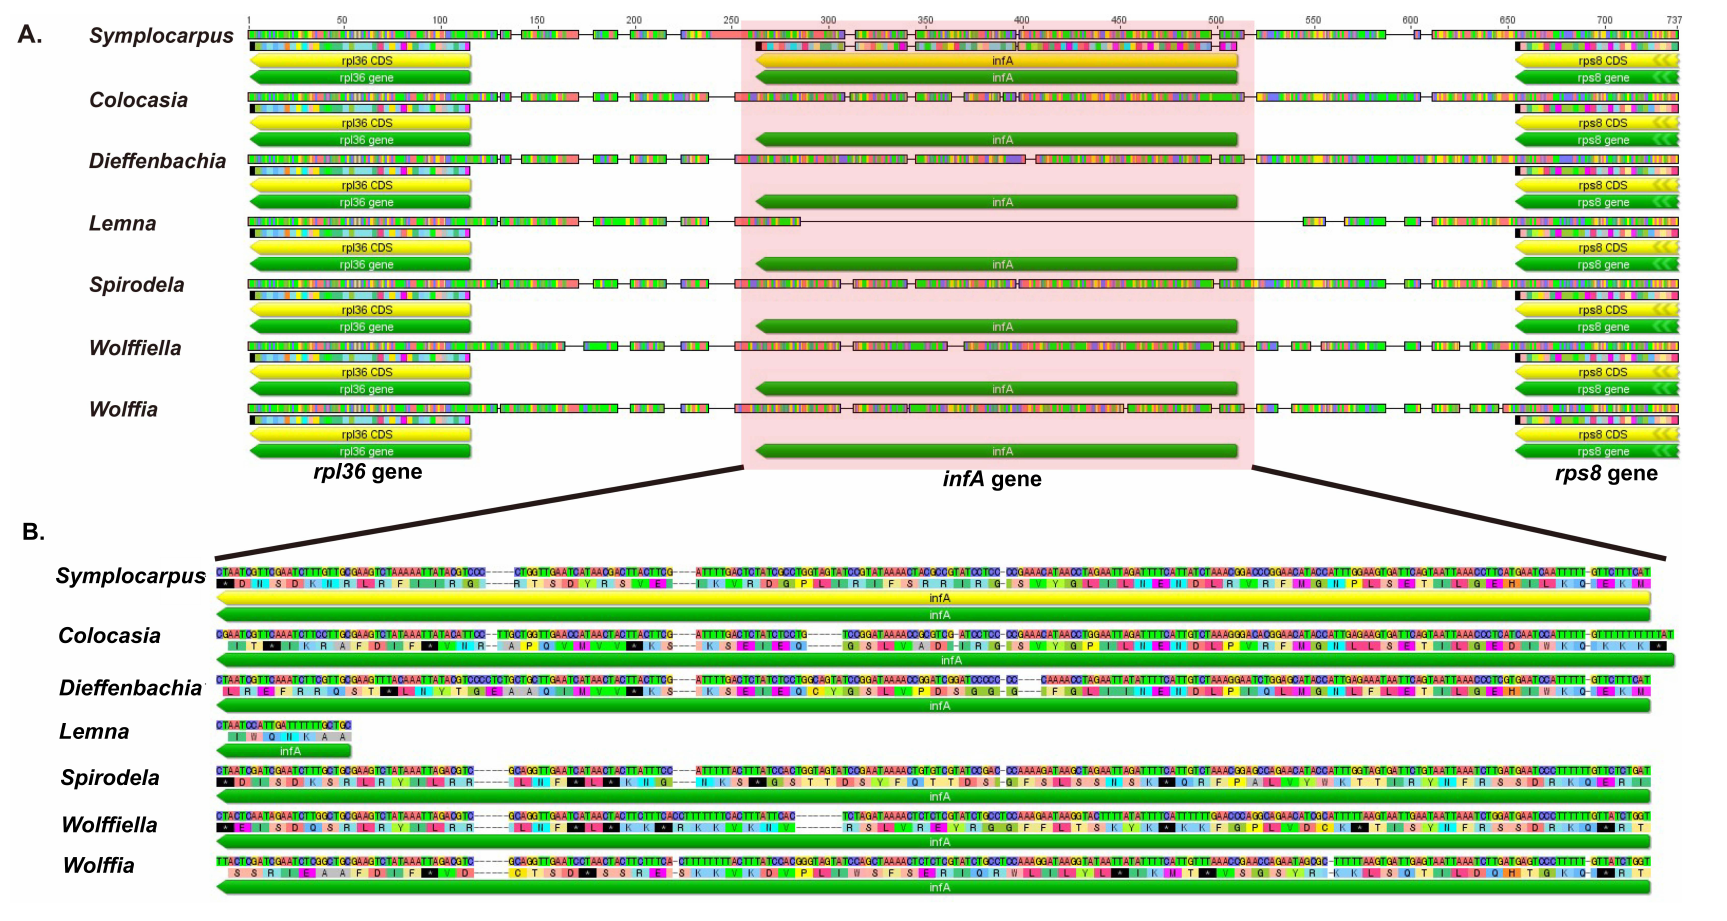
Figure 2. Sequence alignment of the rpl 36 -rps 8 region (including infA ) in seven Araceae species. ( A ) rpl36 - rps8 region; ( B ) infA sequence and its Figure 1. Scheme of the HTC (Hydrothermal carbonization) system for the energy conversion of sludge cake generated at the poultry slaughterhouse wastewater treatment plant.